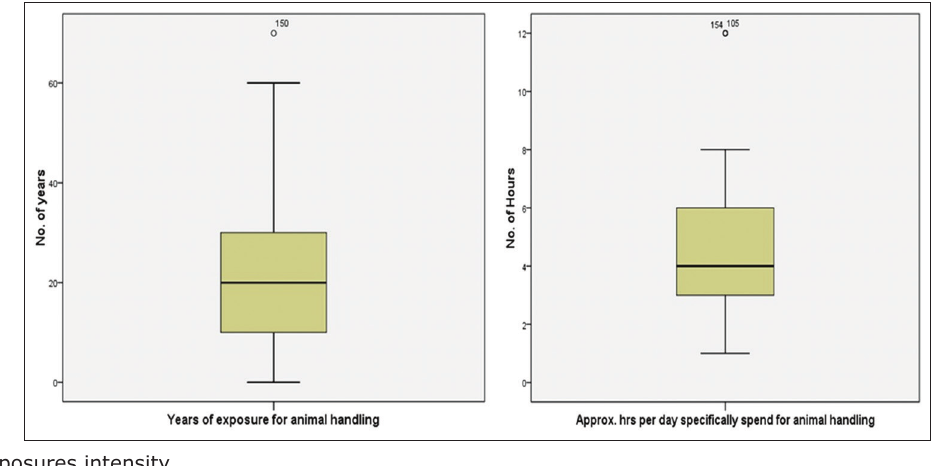
Figure-1: Exposures intensity.